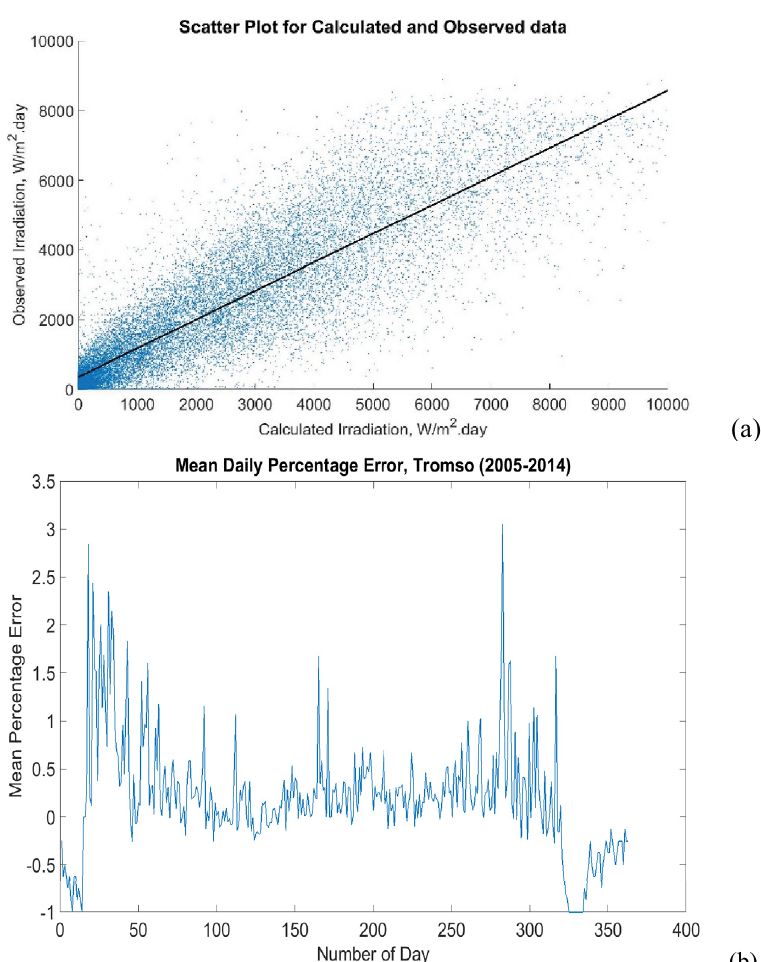
Fig. 2. (a) Scatter plot of the data for calculated and observed values, the correlation coef fi cient for the model is 0.88. (b) Mean percentage error for Tromso, average over 2005 –